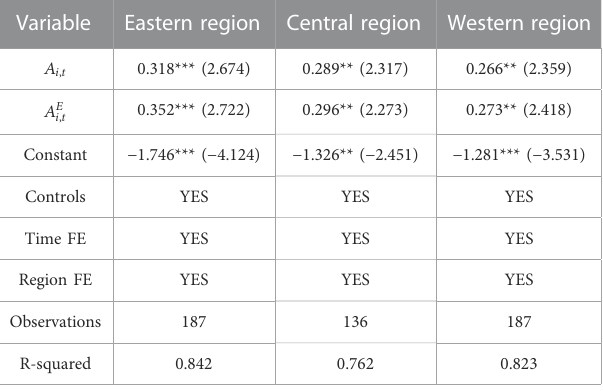
TABLE 4 Regression results of the impact of regional technical progress on carbon productivity of service industry in China. Variable